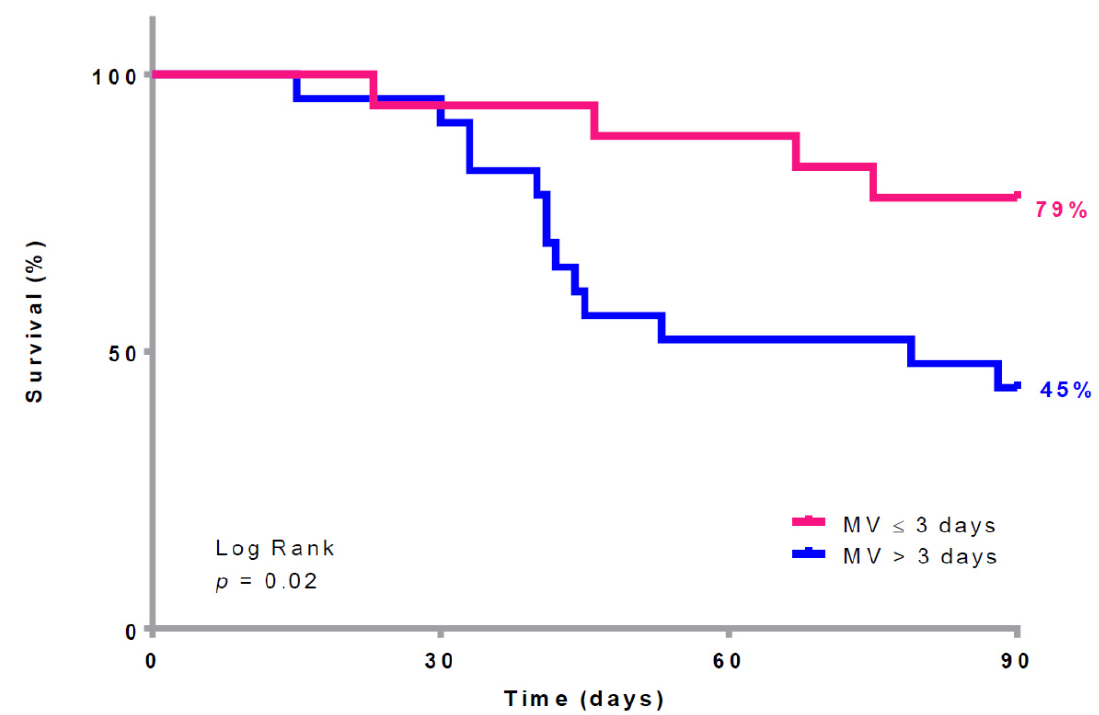
Figure 1. 90-day survival according to the time between mechanical ventilation and ECMO implantation. ECMO: extracorporeal membrane oxygenation; MV: mechanical ventilation.